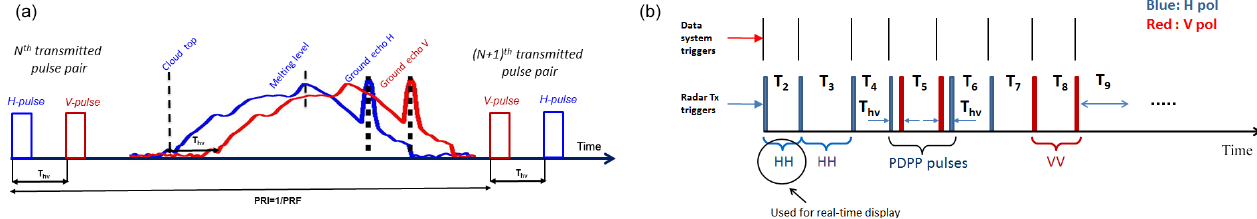
Figure 1. (a) Schematic for the polarization diversity pulse mode. The terms H - and V - refer to the polarization state of the outgoing pulses. Pairs of H and V pulses are transmitted with a pulse-pair interval T hv and with a pair repetition interval PRI. Each V – H pair is followed by an H – V pair. Between transmitted pulses, the H (blue) and V (red) receivers sample the backscattered power. (b) A group of 10 pulses (PP10 mode) that contain regular staggered pulse pairs and a PDPP waveform was implemented in the NRC airborne W-band radar system.